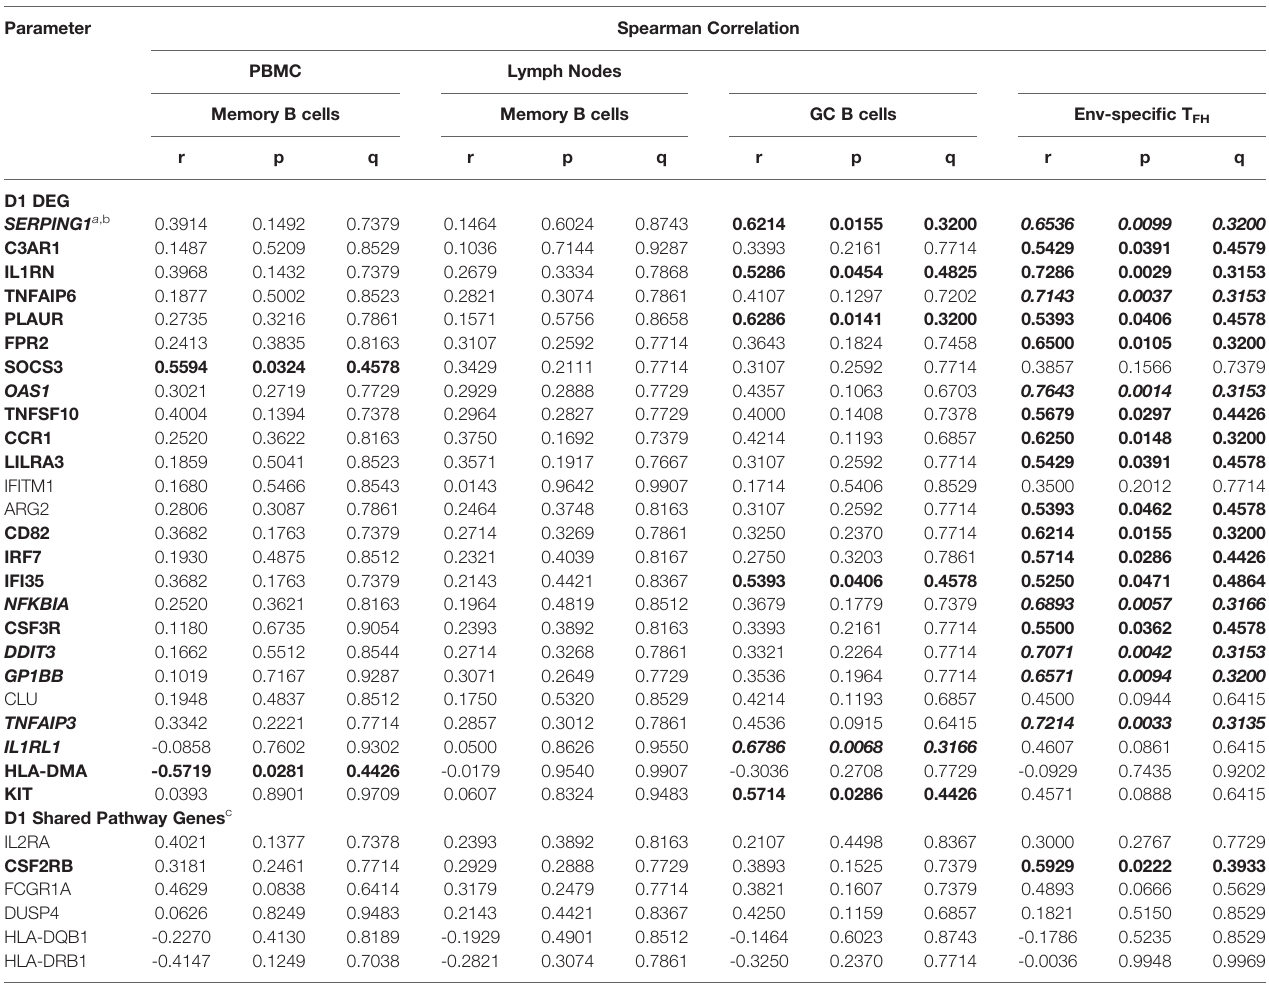
TABLE 5 | Correlation of early gene expression with follicular T helper cells (T FH ) or with memory or germinal center (GC) B cells (week 34).